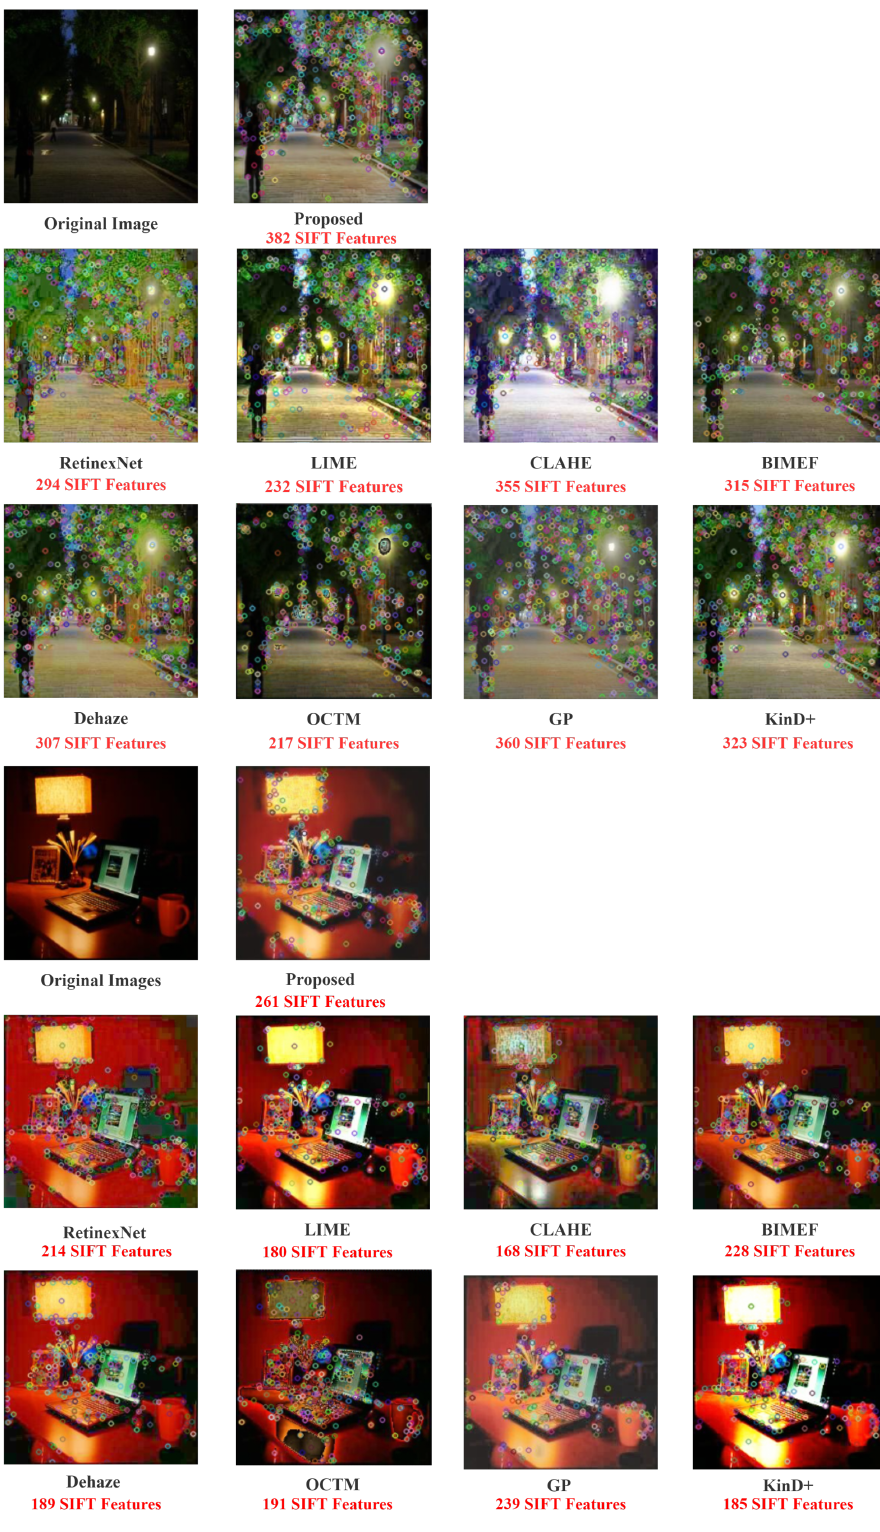
Figure 12. The enhanced image with their number of